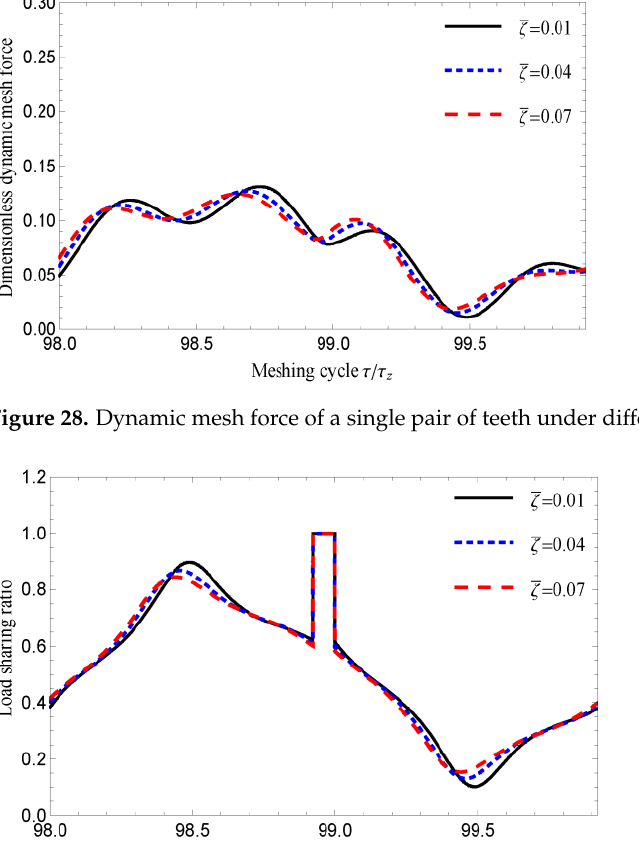
Figure 27. Total dynamic mesh force under different 𝜁̅ .